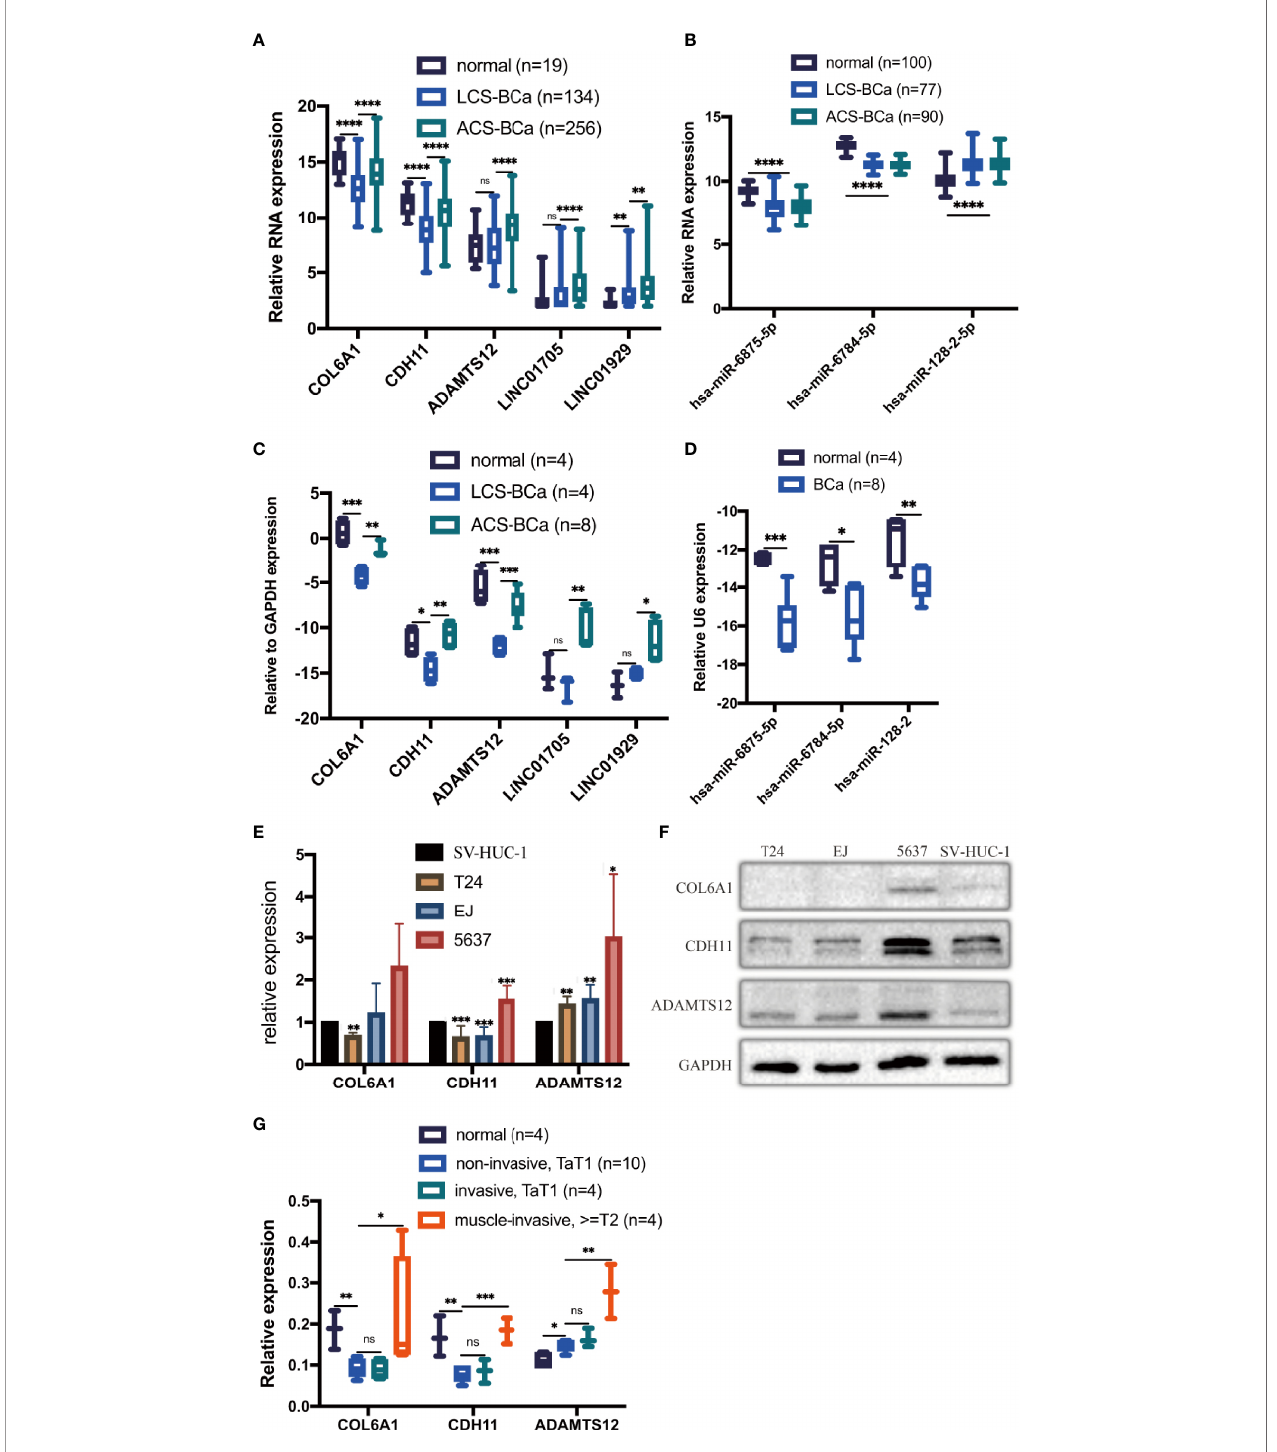
FIGURE 6 | Expression trends of 2 chosen lncRNAs, 3 mRNAs, and 3 miRNAs were veri fi ed using experiments. Relative expression of mRNAs, lncRNAs, and miRNAs in BCa tissues was analyzed using DE analysis of bioinformatics data (A, B) . Relative expression of mRNAs, lncRNAs, and miRNAs in BCa patient tissues was measured using qRT-PCR (C, D) . Relative expression of 3 proteins extracted from BCa cell lines and an immortalized uroepithelial cell line was measured using WB (E, F) . Relative expression of 3 proteins in BCa patient tissues was measured using IHC (G) . *P < 0.05; **P < 0.01; ***P < 0.005; ****P < 0.001. The extended form of “ ns ” is “ no signi fi cance ” , which means that there is no statistical difference between the two